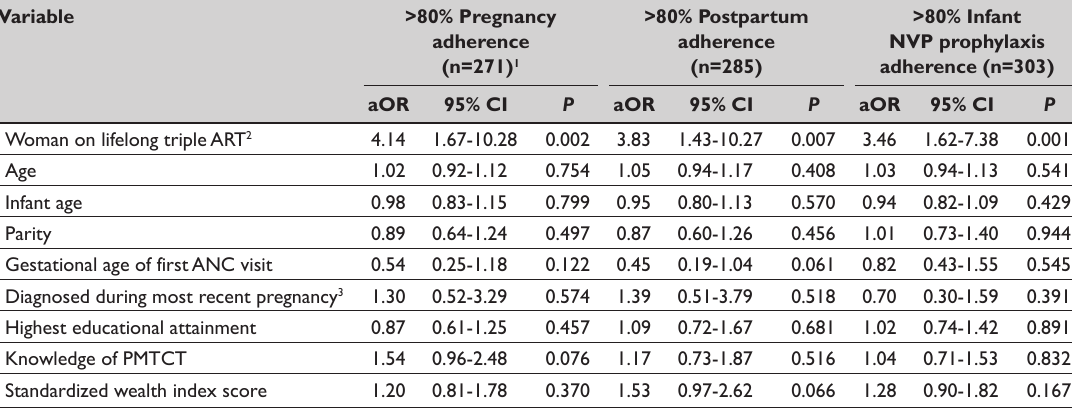
Table 2: Logistic regression results for the odds of drug adherence across the PMTCT continuum of care by type of regimen and covariates